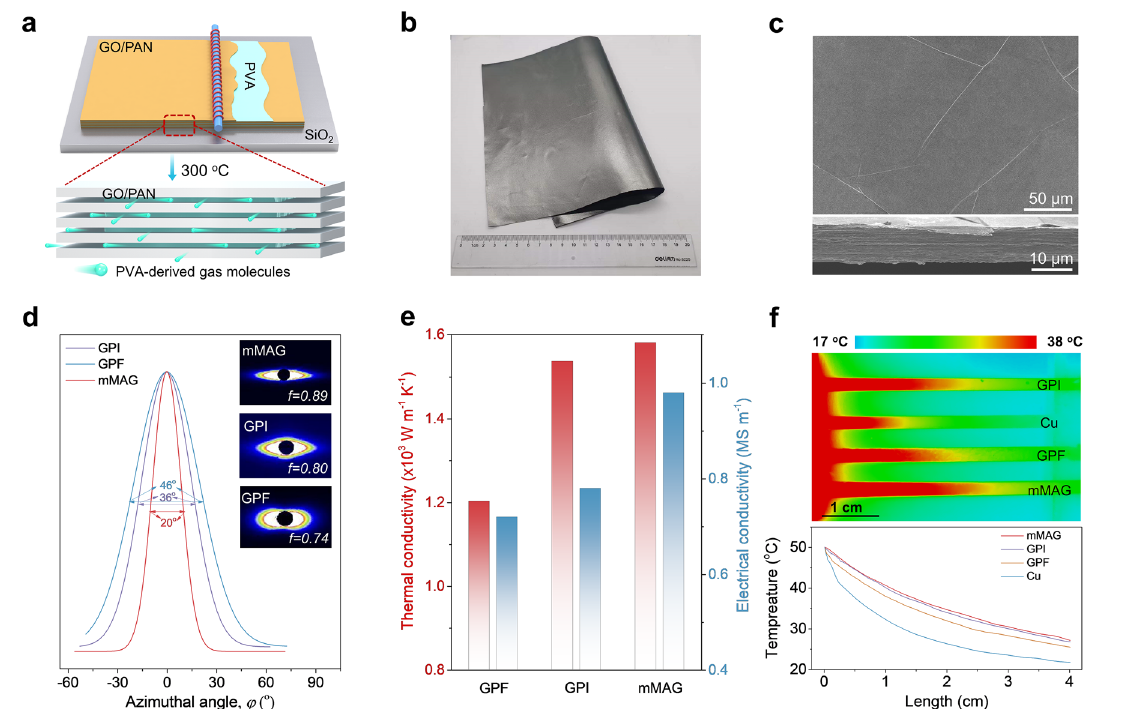
Fig. 5 Thermal properties of 10-μm-thick mMAG assembled from 200-nm-thick nMAGs. a Schematic diagram of the layer-by-layer assembly of GO/PAN film (400 nm per layer) and PVA (5–20 nm per layer) to form a 10-μm-thick mMAG after 3,000 °C heat treatment (Up) and a sche- matic diagram of PVA decomposition during the pre-oxidation process (Down); yellow and gray films are PAN/GO films before and after pre- oxidation, and the green ones are PVA. b Optical image of mMAG. c SEM images of mMAG surface and cross-section, showing the ultralow density of microfolds. d Azimuthal angle ( φ ) plots of scattering patterns by SAXS and the corresponding 2D SAXS patterns (insets) for mMAG, GPI, and GPF films. e Thermal and electrical conductivities of mMAG, GPI, and GPF films. f Infrared thermal images and the corresponding temperature profiles of 10-μm-thick GPI, Cu, GPF, and mMAG with one side tightly attached to a thermostatic